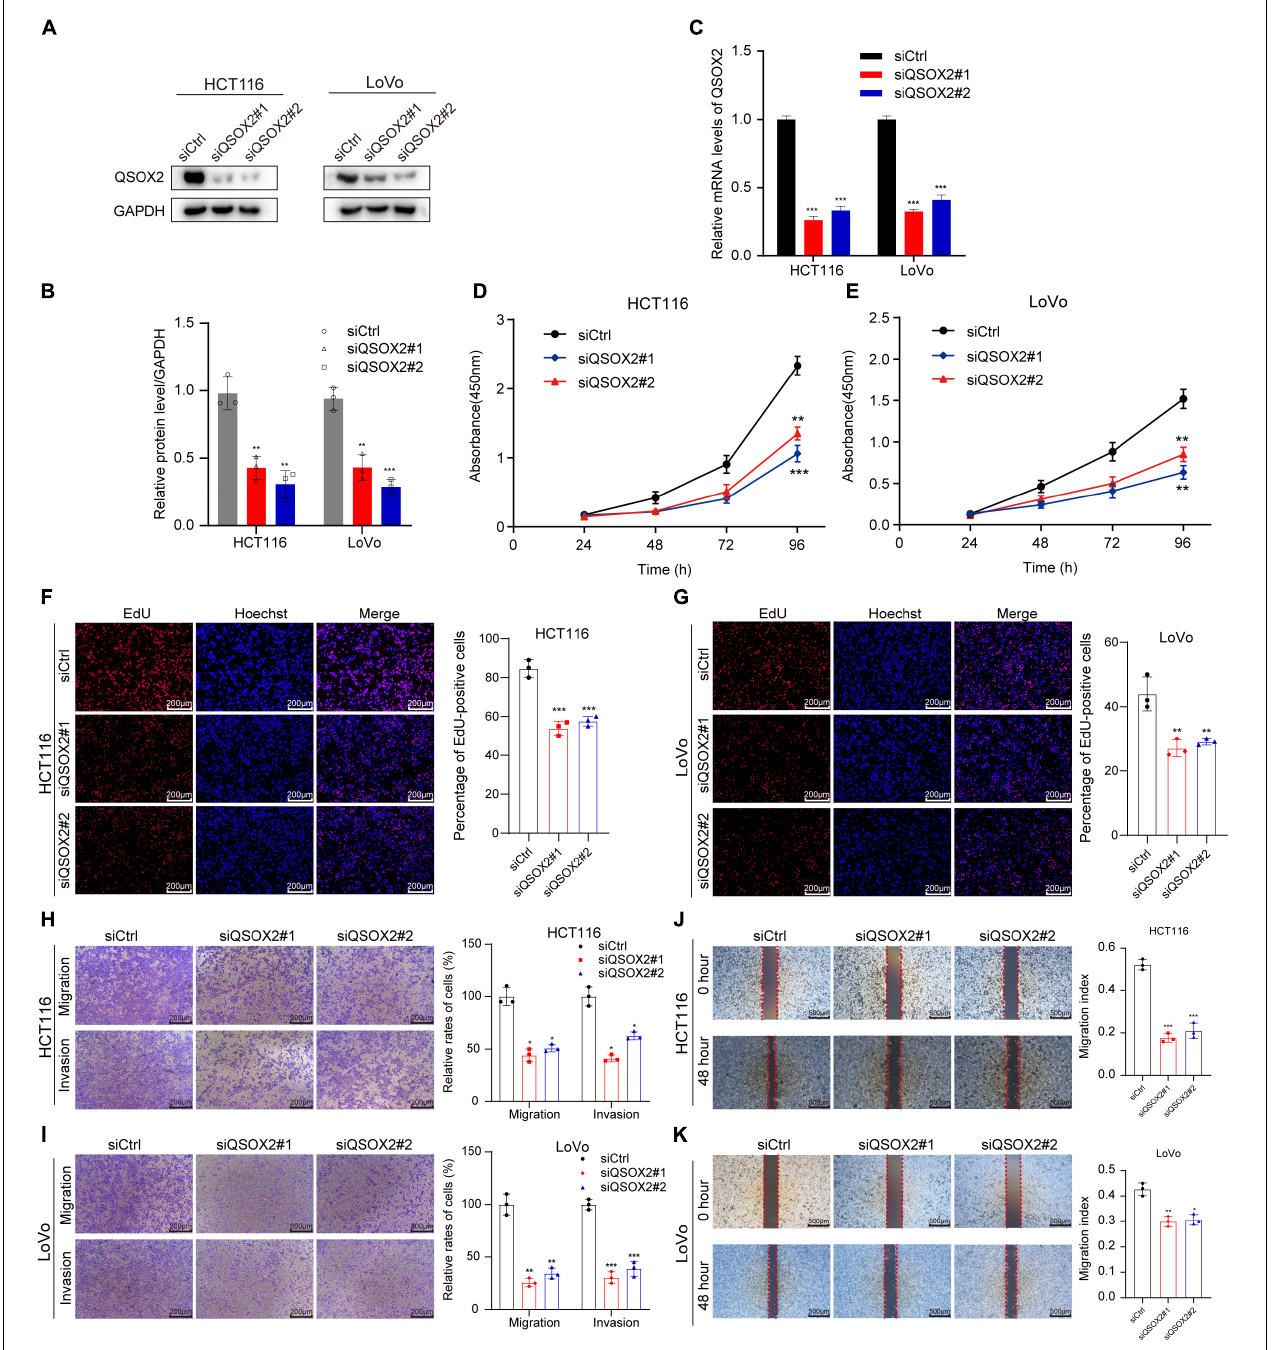
FIGURE 4 | QSOX2 promotes CRC cell proliferation, migration, and invasion in vitro . (A–C) The inhibition of QSOX2 protein and mRNA expression was confirmed in HCT116 and LoVo cells by Western blotting and qRT-PCR, respectively. Densitometry values of QSOX2 normalized to GAPDH. (D,E) QSOX2 inhibition significantly reduced ability of proliferation in HCT116 and LoVo cells via cell counting kit 8 (CCK-8) assay. (F,G) QSOX2 inhibition significantly reduced ability of proliferation in HCT116 and LoVo cells via 5-ethynyl-2 (cid:48) -deoxyuridine (EdU) incorporation assay. (H,I) Inhibition of QSOX2 significantly suppressed the ability of migration and invasion in HCT116 and LoVo cells via Transwell assay. (J,K) Inhibition of QSOX2 significantly inhibited the wound healing speed in HCT116 and LoVo cells by wound healing assay. All experiments were repeated three times, and the final data are shown as mean ± standard deviations. * p < 0.05; ** p < 0.01; *** p < 0.001.